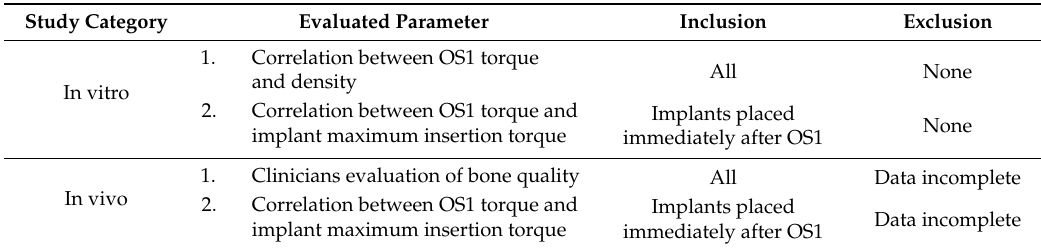
Table 1. Summary of evaluations and inclusion/exclusion criteria.